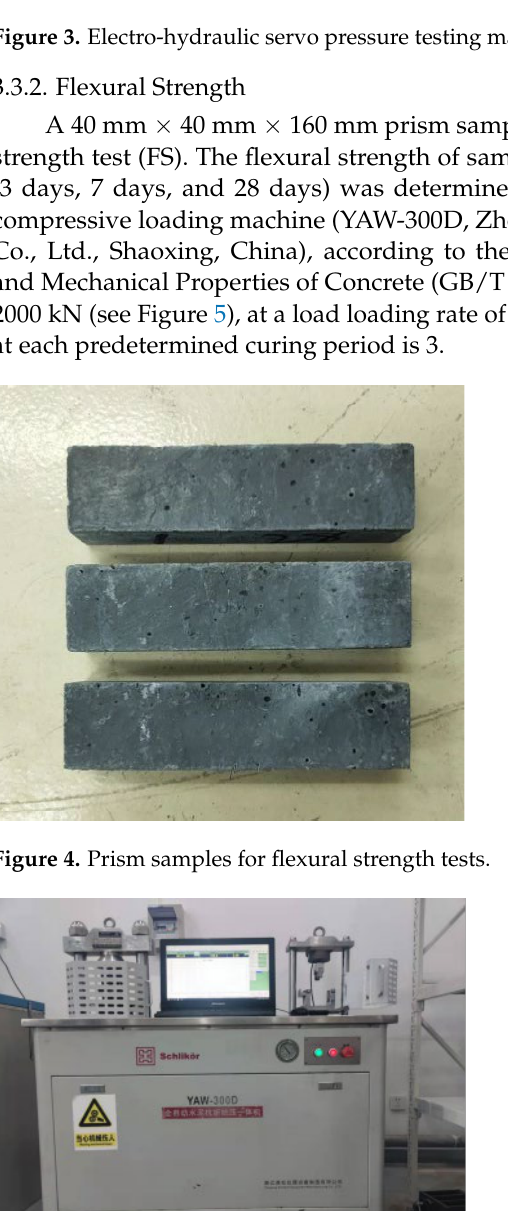
Figure 3. Electro-hydraulic servo pressure testing machine.